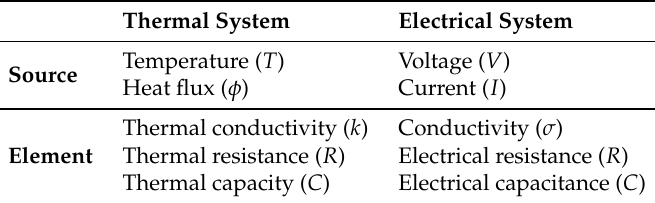
Table 1. Thermal to Electrical system